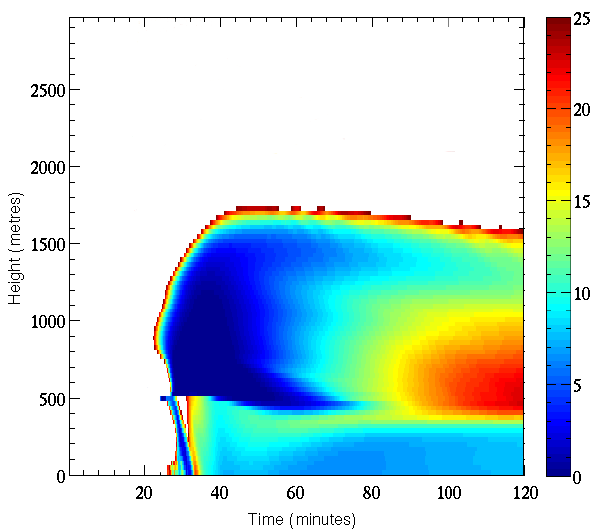
Fig. 6. Time-height plot of the diagnosed shape parameter for rain from the bin scheme, obtained through the method of moment-conserving fits (see appendix A). The plot shown is from the CCN=50/cc case, with w 1 =0.5ms − 1 and T =RICO